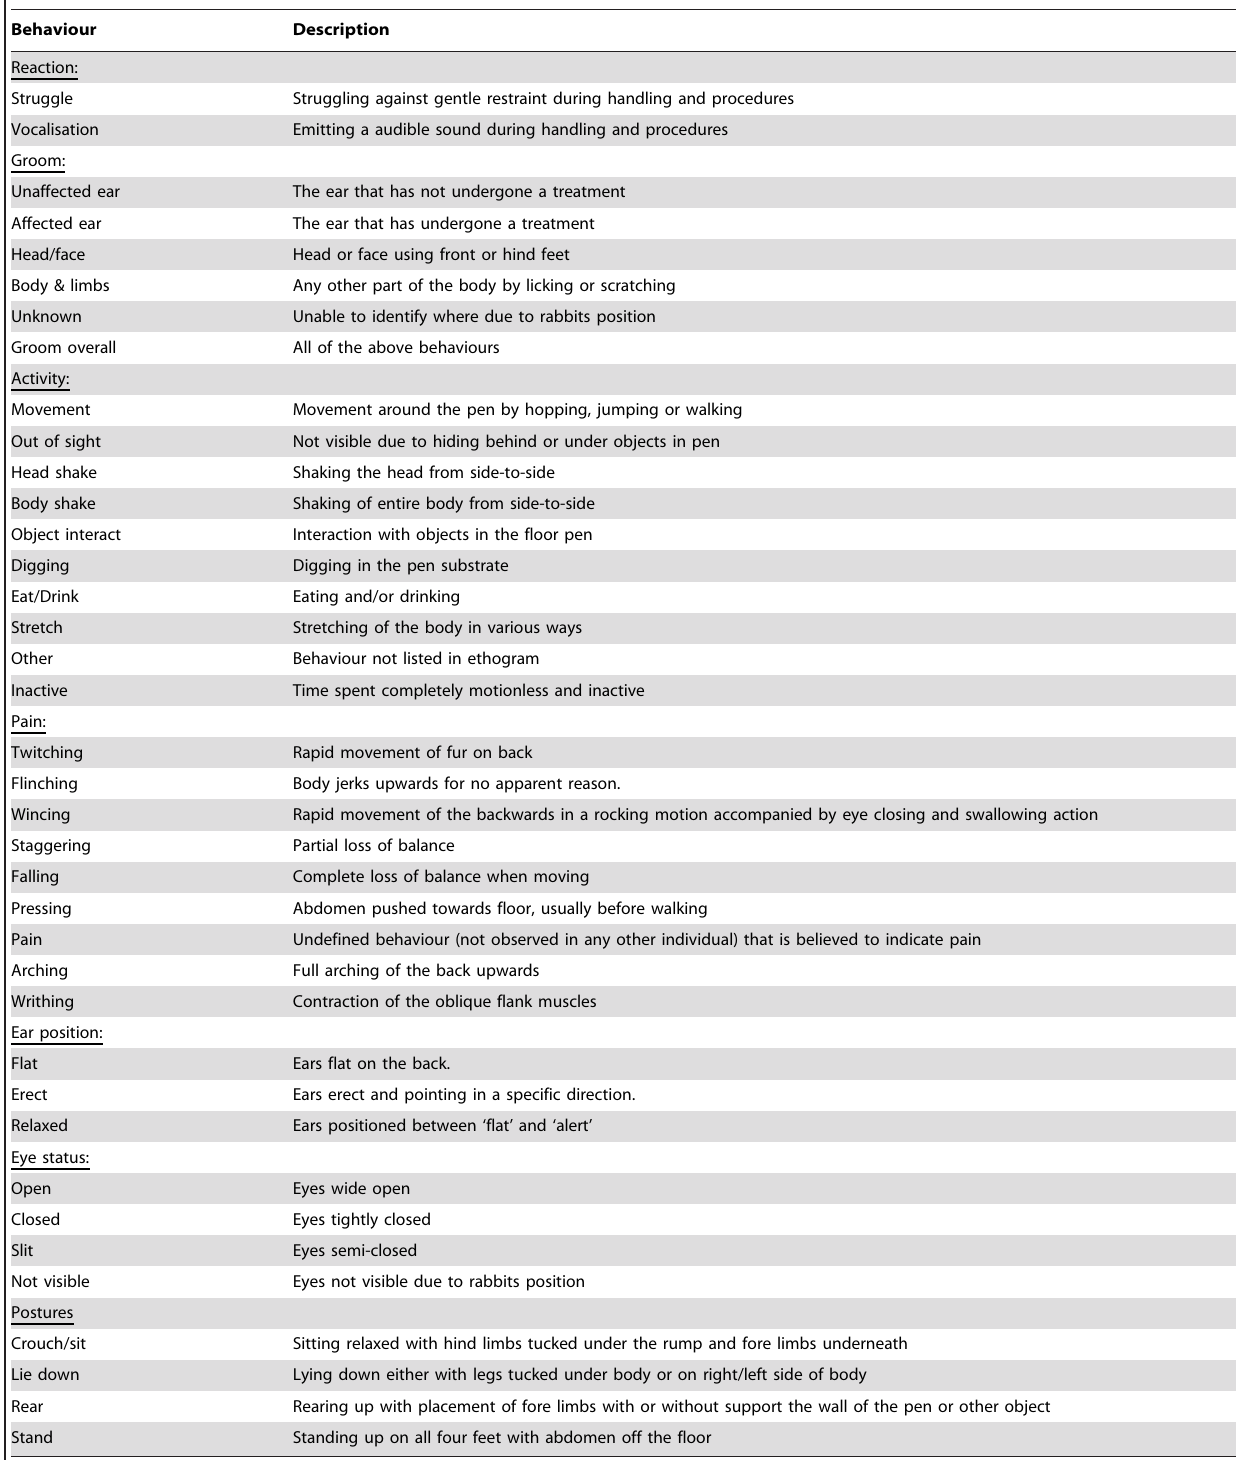
Table 2. Ethogram of rabbit behaviour (adapted from Leach et al. [17]).